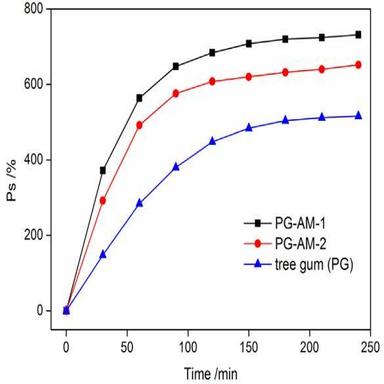
Swelling capacity of tree gum (PG) and grafted copolymer (PG-AM) at room temperature: For PG-AM-1, Pg = 266, GE = 88.7; For PG-AM-2, Pg = 150, GE = 75.